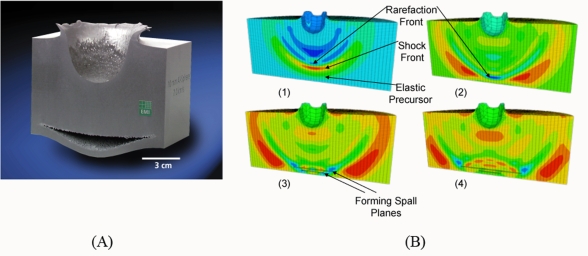
Spallation failure in a semi-infinite aluminium target after impact by a 10mm aluminum sphere at 7km/s. (a) Target after impact experiment cut into half. (b) Hydrocode simulation of the impact and related shock propagation leading to the formation of spallation planes.